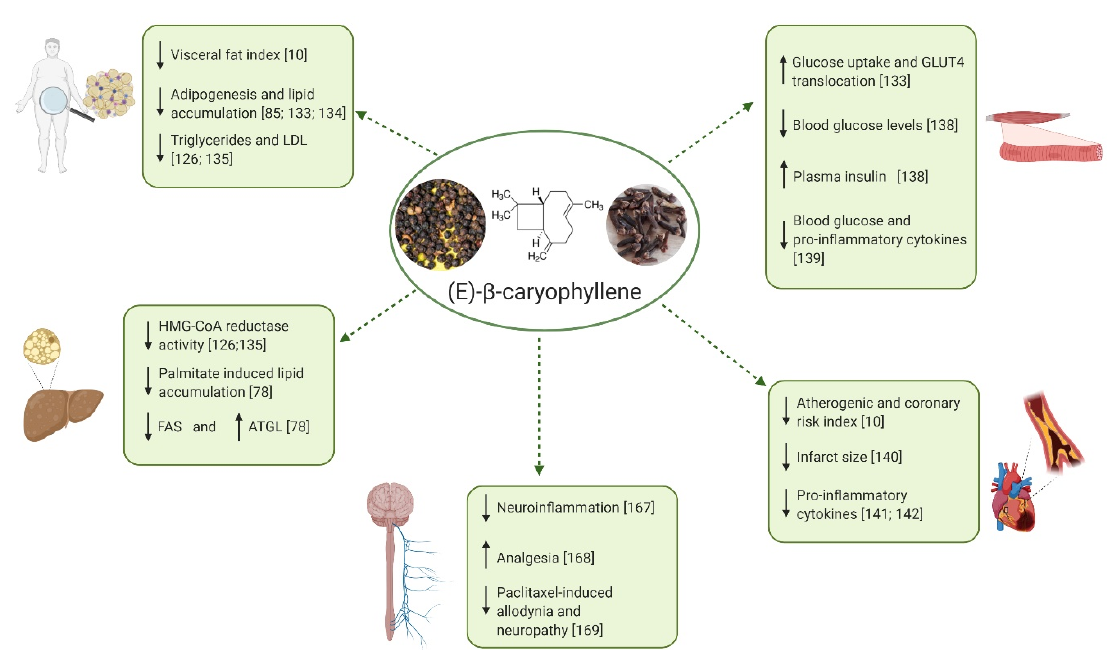
Figure 2. Positive effects of BCP on metabolic and neurological disorders. Scheme created with BioRender.com. ↓ : reduction; ↑ : increase; LDL: Low density lipoproteins; HMG-CoA: Hydroxy methylglutaryl-Coenzyme A; FAS: fatty acid synthase; ATGL: adipose triglyceride lipase; GLUT4: glucose transporter 4.